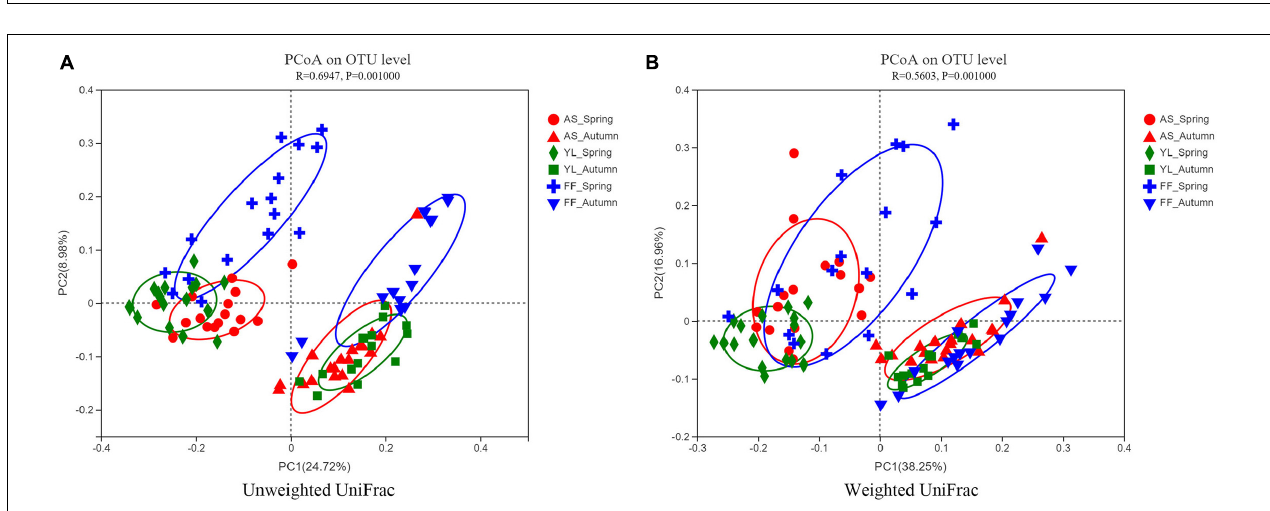
FIGURE 4 | Principal coordinate analysis (PCoA) plots of phyllosphere bacterial communities using the unweighted UniFrac method (A) and weighted UniFrac method (B) at OTU level among A. spanostachya (AS), Y. lineolate (YL), and F. ferax (FF) in spring and autumn.